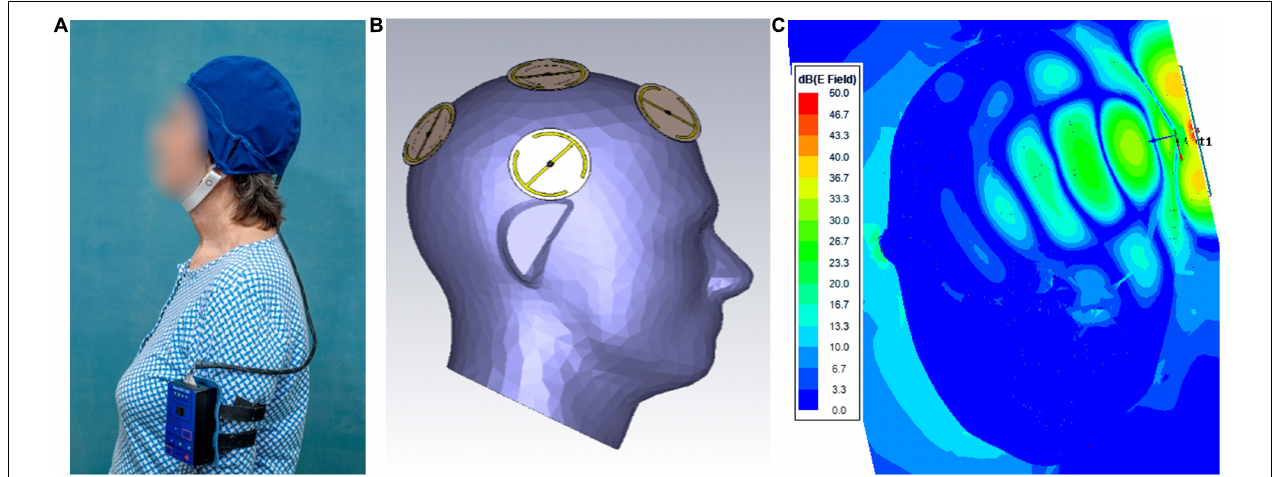
FIGURE 1 | (A) A MemorEM TM device being worn by a subject. The control panel/battery box is worn on the upper arm and wired via a cable to eight electromagnetic emitters in the head cap. (B) Position of the eight electromagnetic emitters (four on each size of the head) embedded between the device’s two-layered head cap. Emitters collectively provide full forebrain TEMT via rapid sequential activation. (C) FDTD brain simulation of electric field showing penetration and distribution from a single emitter at a SAR power level of 1.6 W/kg. The head/emitter interface is the thin blue margin below the bow tie-like electric field generated by the